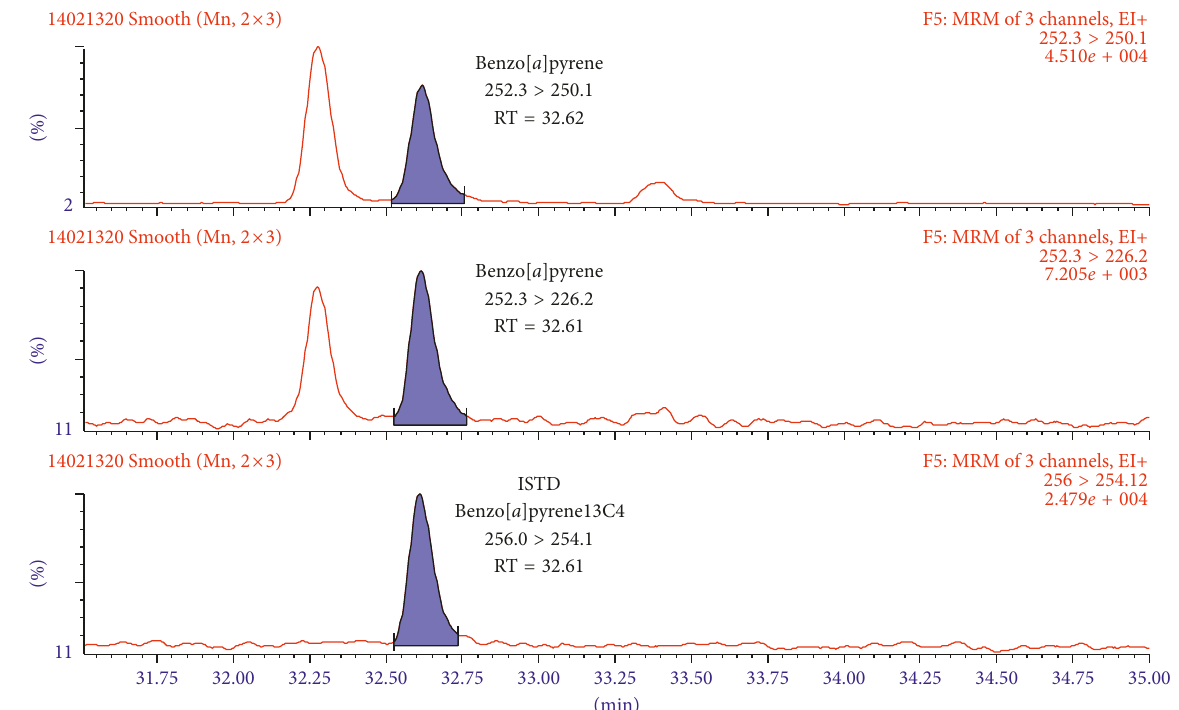
1 in a meat sample. kg · −